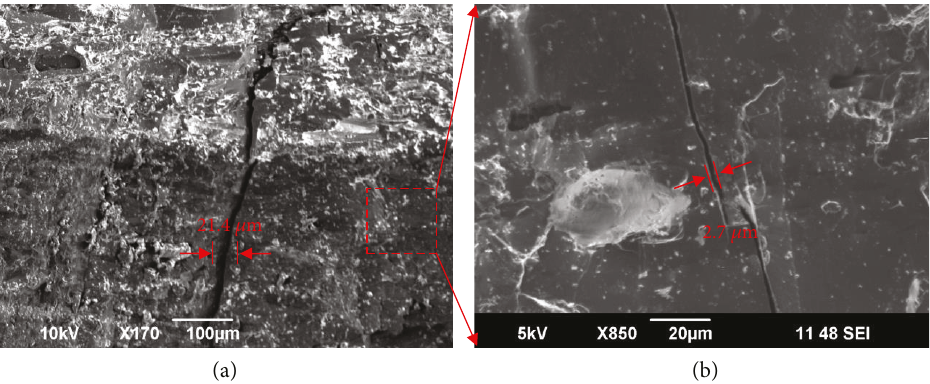
Figure 7: SEM images showing coal fracture in easy-to-drain areas.